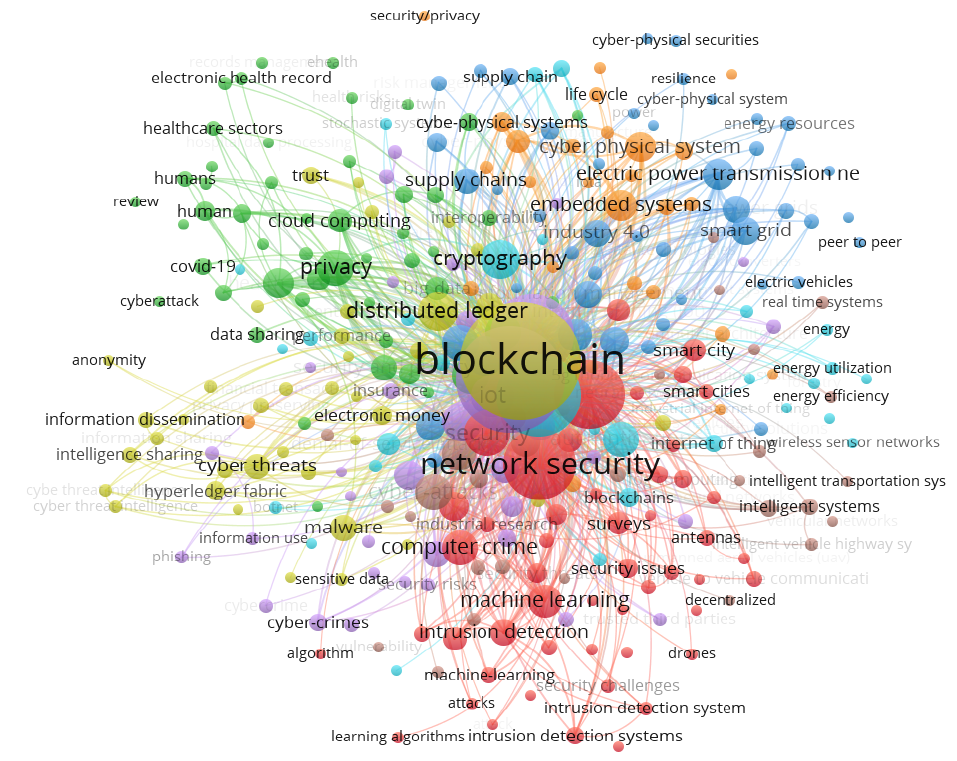
Figure 11. Keyword network for “blockchain” and “cybersecurity.”